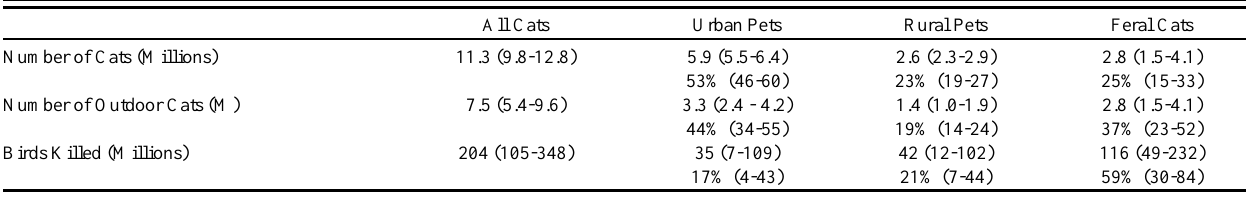
Table 4 . Estimates of cats and birds killed by cats in Canada, based on parameter values in Table 3. Values are medians across 10,000 iterations, with 95% range of estimates in parentheses.